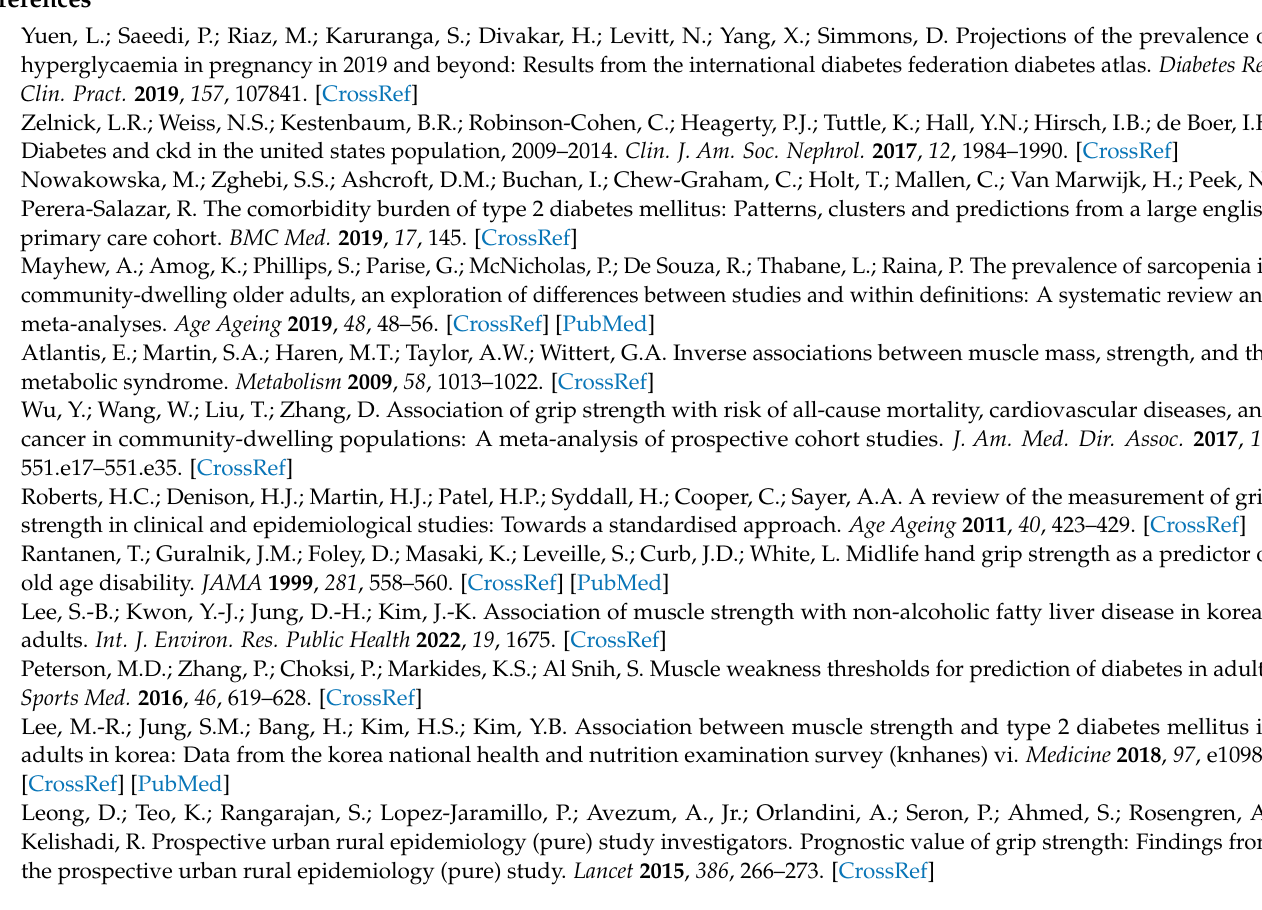
0.1 kg) and the prevalence of DM in Koreans using logistic regression. Table S2. Model diagnostics for logistic regression of Table 2. Table S3. Model diagnostics for logistic regression of Table 3. Table S4. Odds ratio and 95% confidence intervals for the prevalence of DM according to RGS quartile. Figure S1. ROC curve predicting prevalence of DM according to RGS (per 0.1 kg) in men in unadjusted model (A), and model 3 (B), in premenopausal women in unadjusted model (C), and model 3 (D),